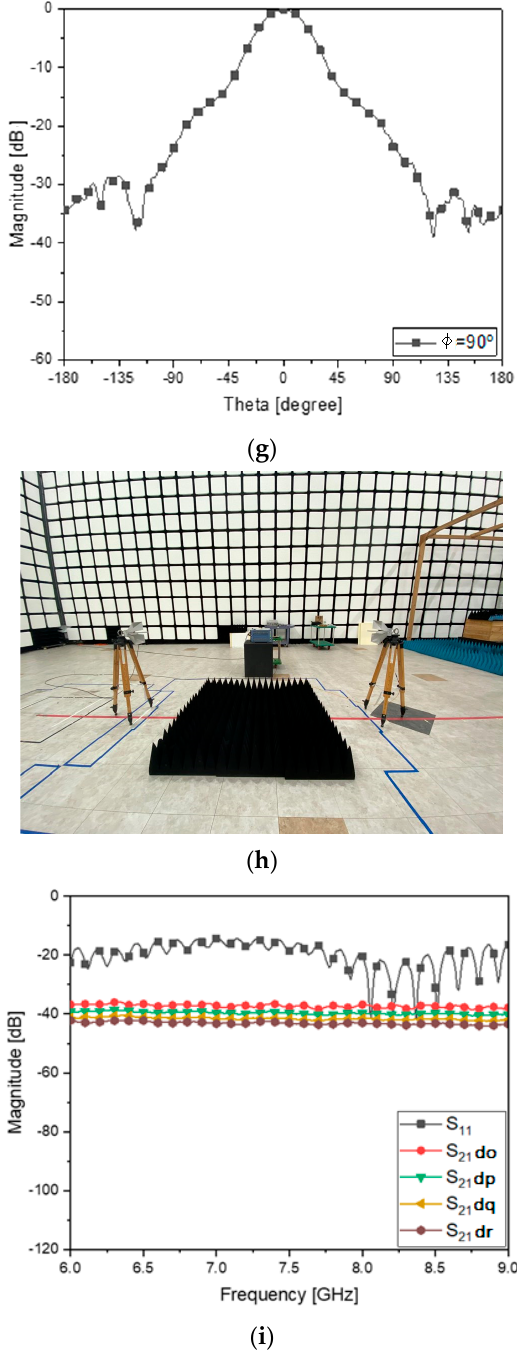
Figure 10. RF − link tests of the horn antennas without and with the BPF. ( a ) Signal transfer between the TX and RX horn antennas. ( b ) Case of the TX as the filtenna. ( c ) Horn antenna standing on either of the TX and RX sides. ( d , e ) S 11 of the horn antenna. ( f ) Far − field pattern on the Φ = 0° plane for the horn antenna. ( g ) Far − field pattern on the Φ = 90° plane for the horn antenna. ( h ) Over − the − air test in the anechoic chamber. ( i ) S 11 and S 21 when the setup is without the BPF with the antenna position adjusted back and forth in a small scale such as 1 cm to 4 cm.